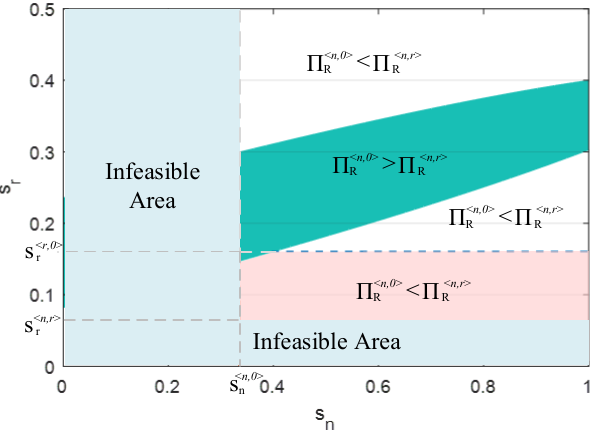
Figure 6. The manufacturer’s prisoner dilemma in < n , 0 > scenario.